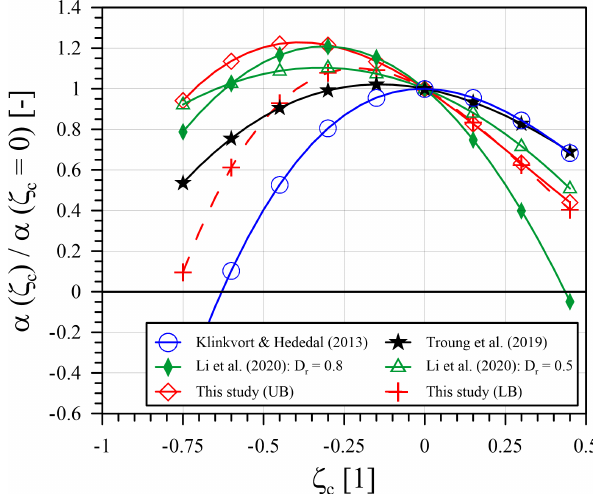
Figure 9. Normalized accumulation parameter ( α ) with cyclic load ratio ( ζ c ) for different approaches and comparison with the pro- posed lower bound (LB) and upper bound (UB)